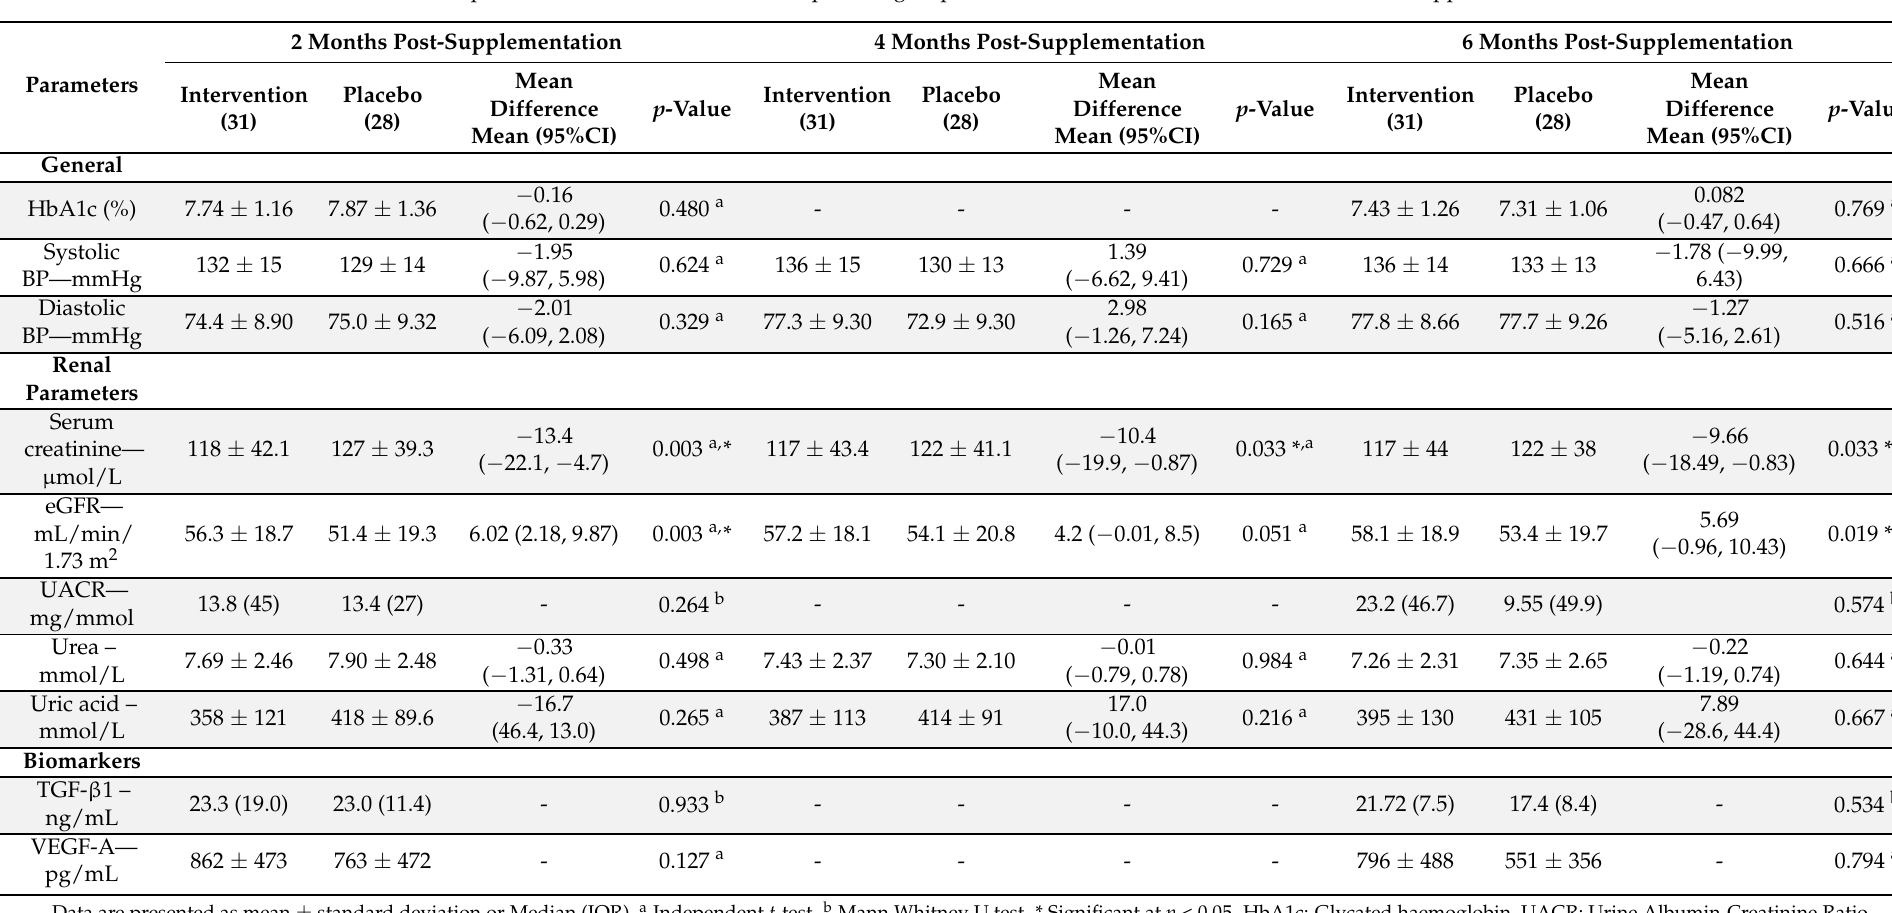
Table 2. Comparison between intervention and placebo group after six months of tocotrienol-rich vitamin E